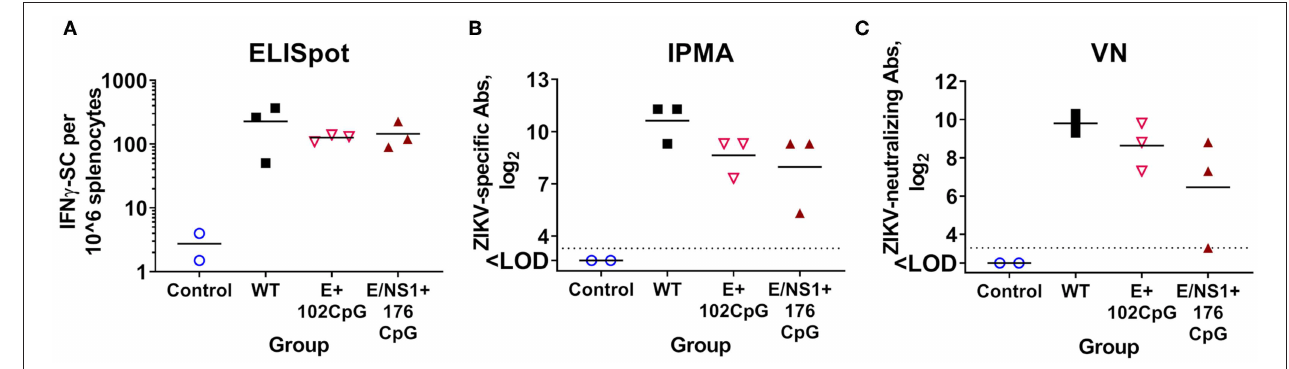
FIGURE 9 | Cellular (A) and humoral (B,C) immune responses in adult mice 28 days after immunization with WT and CpG-recoded ZIKV variants. ELISpot, enzyme-linked immune absorbent spot; IPMA, immunoperoxidase monolayer assay; VN, virus-neutralizing assay. Dotted lines represent the LOD, solid lines represent mean